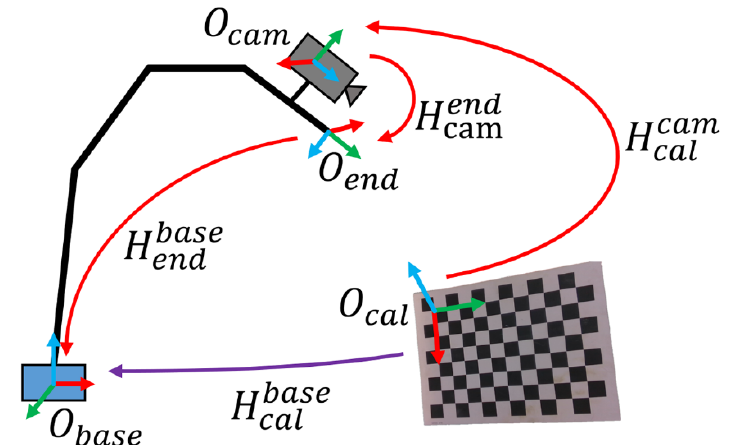
Figure 9. Schematic diagram of hand-eye calibration solution.